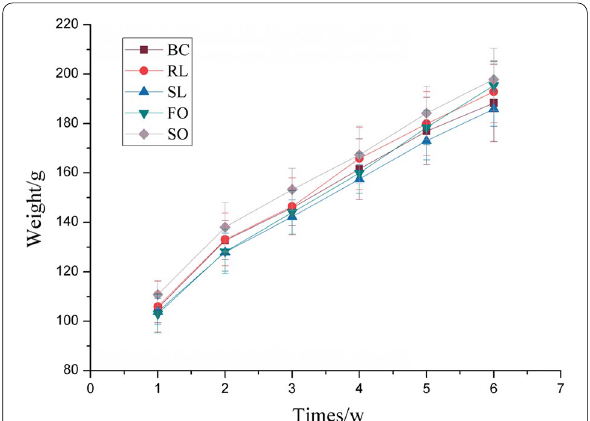
Fig. 1 The body weight of rats fed with stewed lard, refined lard,